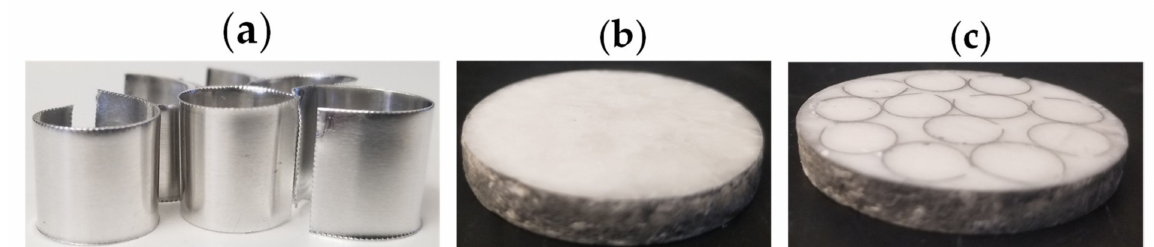
Figure 4. ( a ) Image of aluminum 6061 rings, ( b ) image of PCM without aluminum rings, ( c ) image of eutectic PCM with aluminum rings PCM discs were nominally 8 mm thick and 50 mm in diameter.